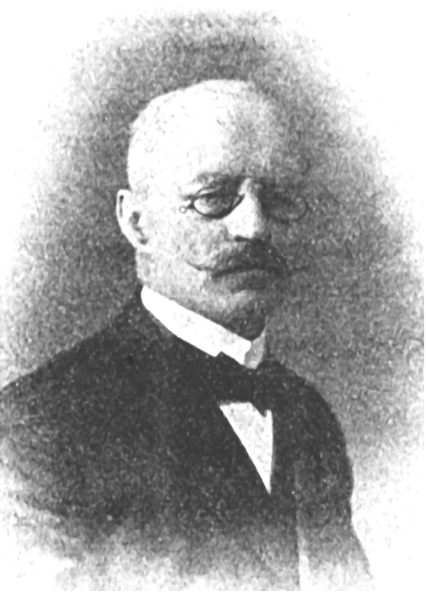
Fig. 4b. Josef Sykora was born in Kharkov in Ukraine in 1874, a son of Czech immigrants. He began his scientific career in as- tronomy at the Kharkov University. His first scientific works, con- cerning observations of the Solar Eclipse in northern Finland and measurements of solar protuberances, were noted by the Russian Astronomical Society. He carried out observations at several astro- nomical observatories; Kharkov, Juriev (now Tartu), Moscow and Pulkovo. After his active participation in the Russian-Swedish ex- pedition to Spitsbergen in 1899–1902 Sykora eventually took up a position at the Tashkent Observatory (now in Republic of Uzbek- istan) where he became head astrophysicist in 1906. His main fields of study there were meteors and comets, but he also continued au- roral studies, using data from the network of meteorology stations in the Murmansk region. He developed photographic methods and equipment both for auroral, meteor and comet research. In 1911 he took up teaching and taught at several gymnasiums and univer- sities. In 1921 he emigrated to Prague where he became professor of astronomy and did important work to raise the quality of photo- graphic astronomical observations in Czechoslovakia. He died in